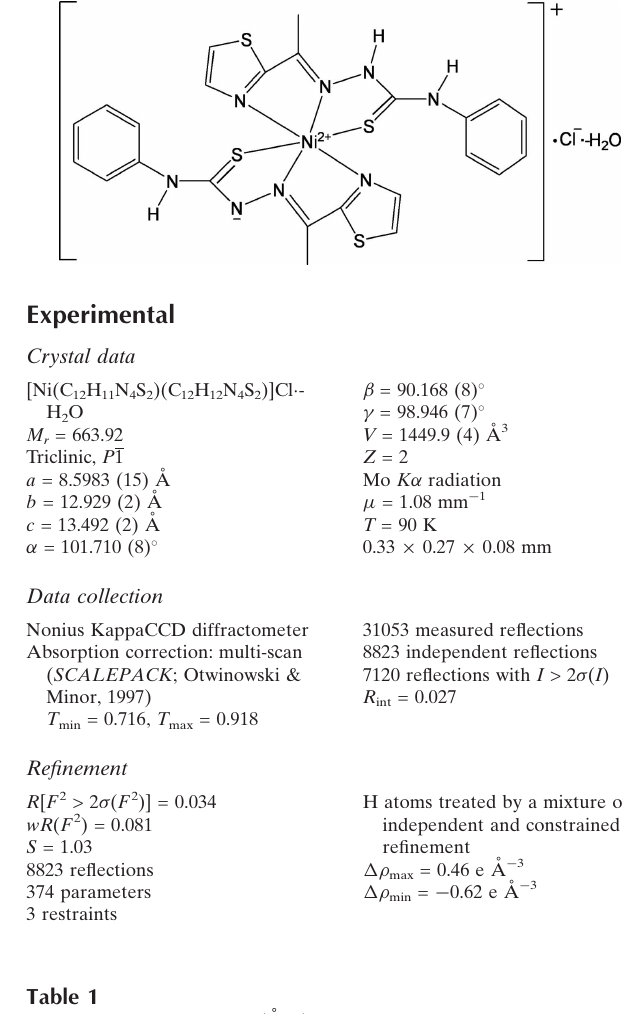
Hydrogen-bond geometry (A˚ , (cid:3)